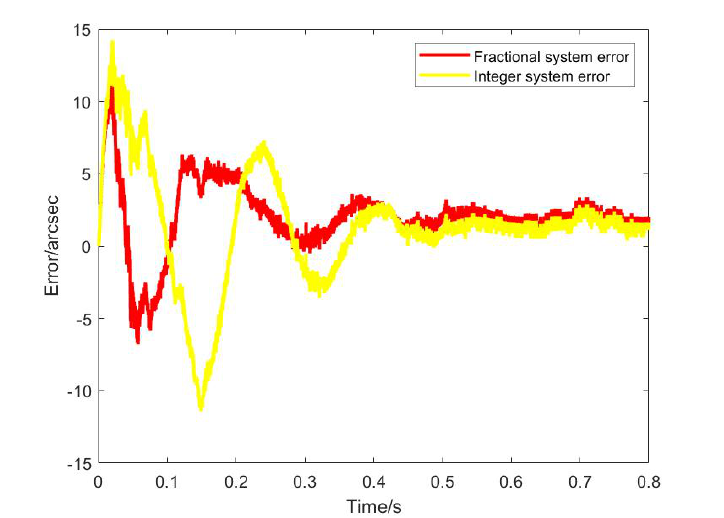
Figure 7. Error comparison of two systems. Fractional systems have less